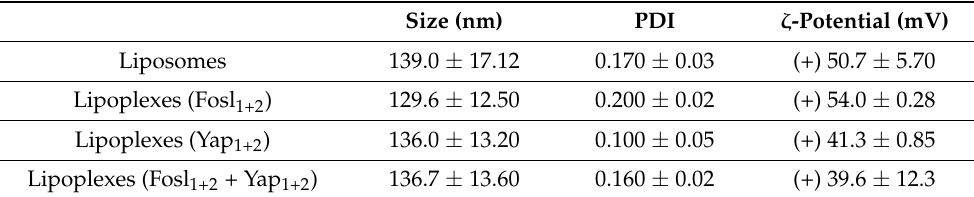
Table 2. Physicochemical characterization of DODAB:MO (1:2) liposomes at 3 mM and lipoplexes at charge ratio ( ± ) 15 containing 2 or 4